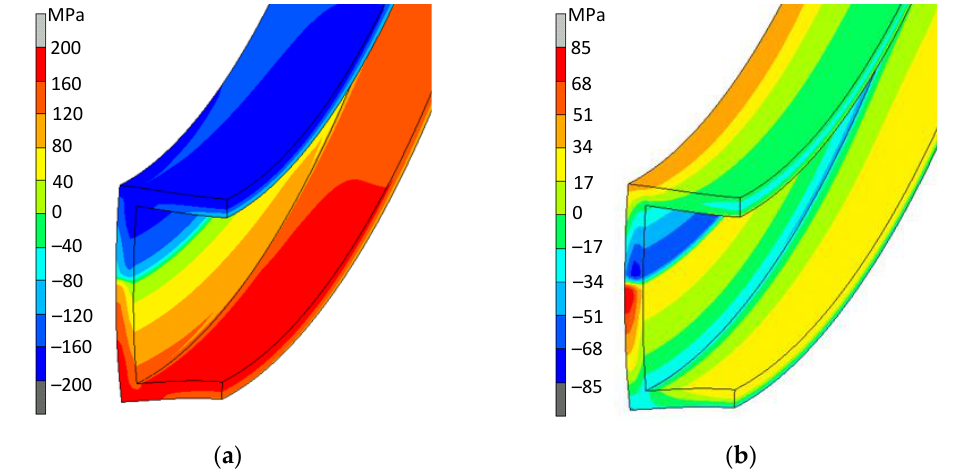
Figure 4. Distribution of axial stresses on the cross-section of a tube with dimensions of 21.5 × 21.5 × 1.8 mm: ( a ) under load, bent to a radius of the value R = 0.138 m, ( b ) after springing (residual stress distribution).